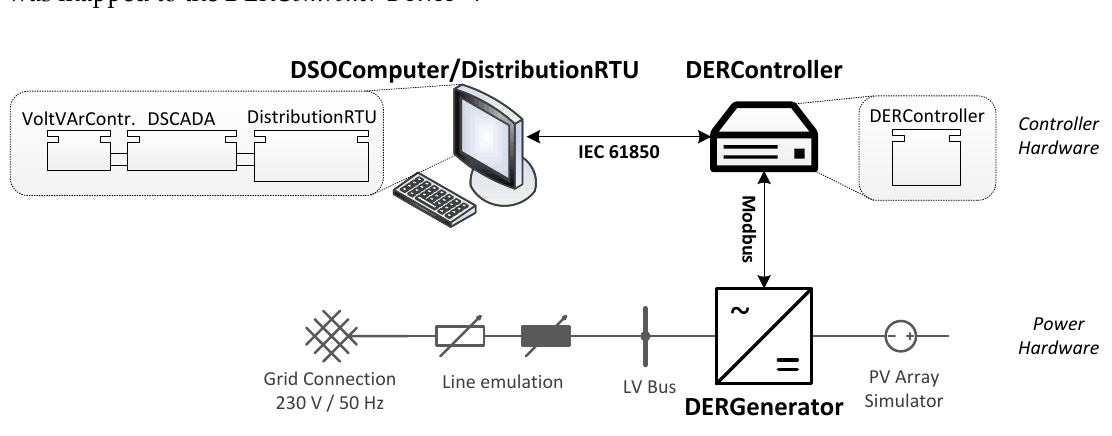
Figure 13. Laboratory setup for the use case